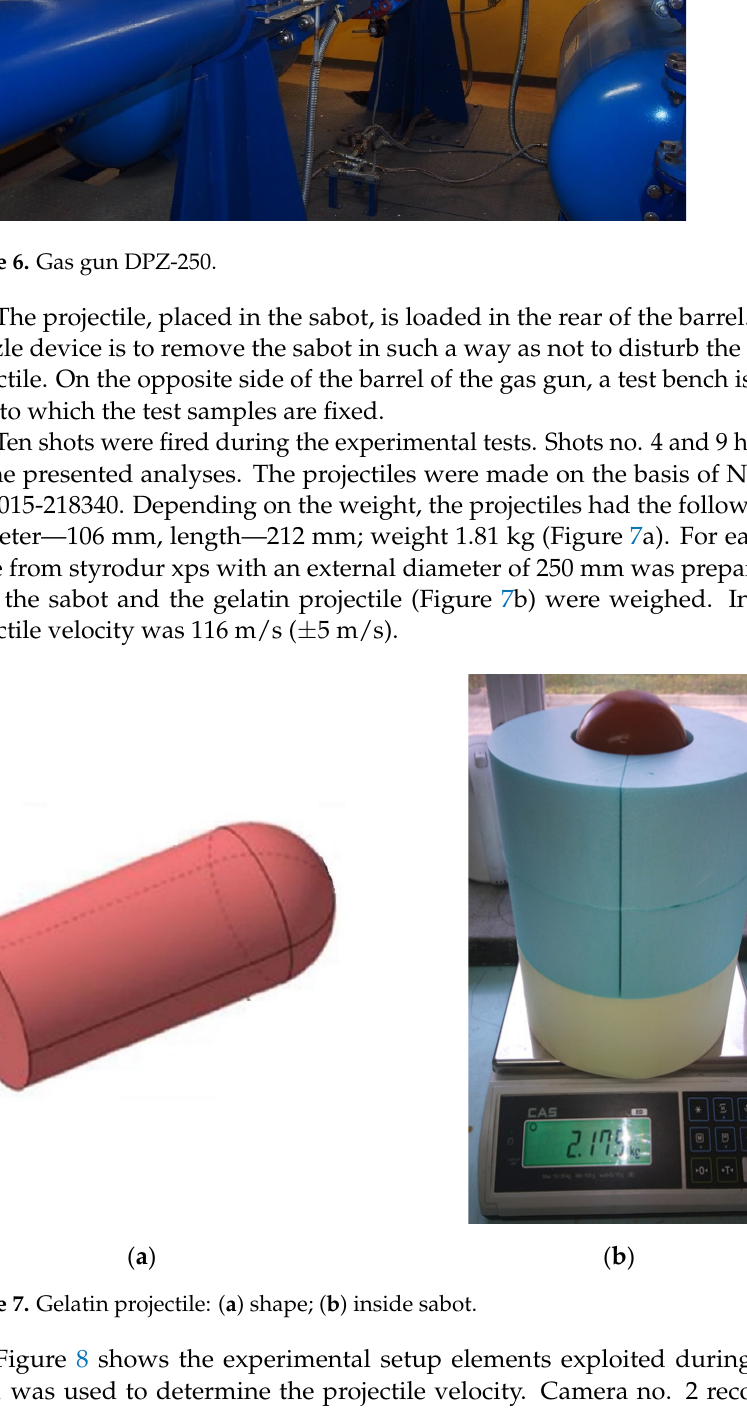
Figure 5. Parts of experimental setup: ( a ) load sensors; ( b ) plexiglass plate with mounted tensiome- ters; ( c ) steel rigid plate.